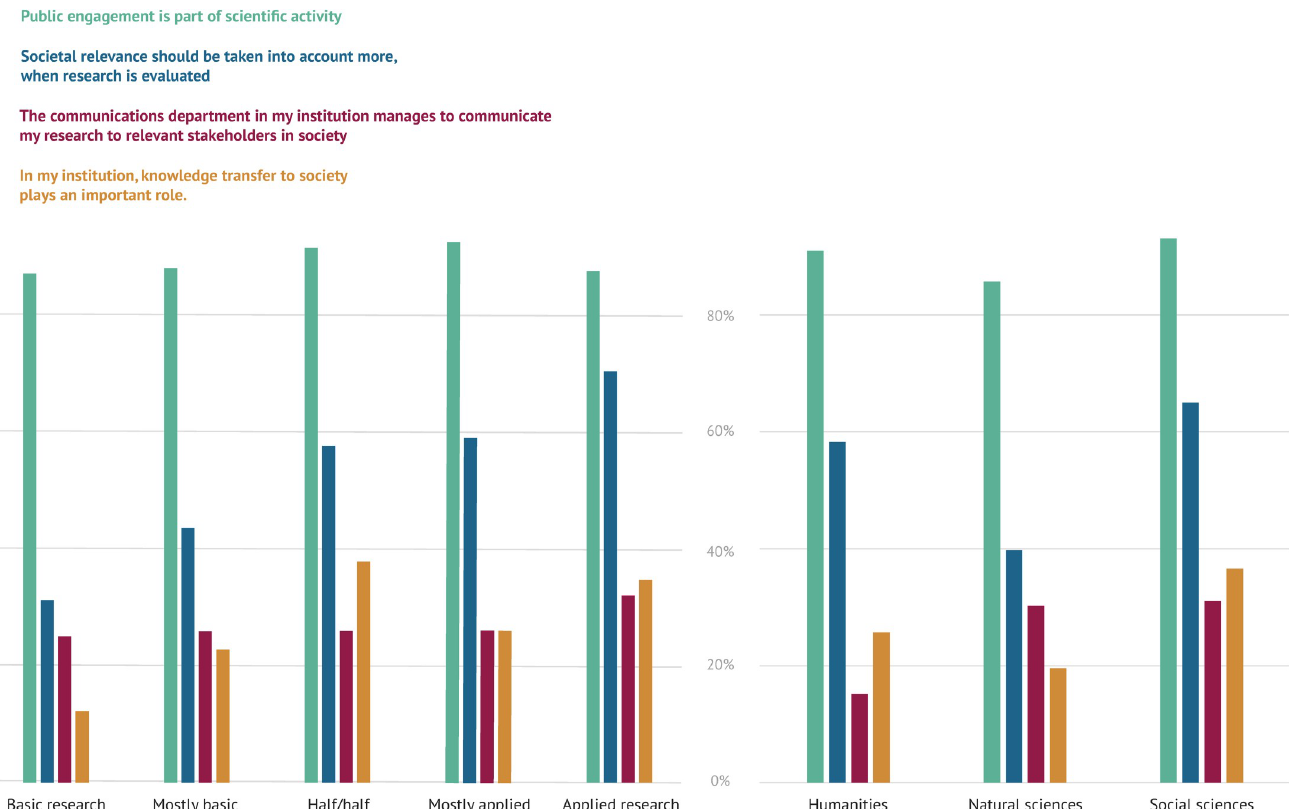
Fig 2. Researchers’ opinions on four core statements regarding societal impact. The responses are differentiated by how much the researchers consider their work to be basic or applied research and the three disciplinary groups. The original question text was “How strongly do the following statements apply to you?.” We combined the approving answer categories to calculate the approval